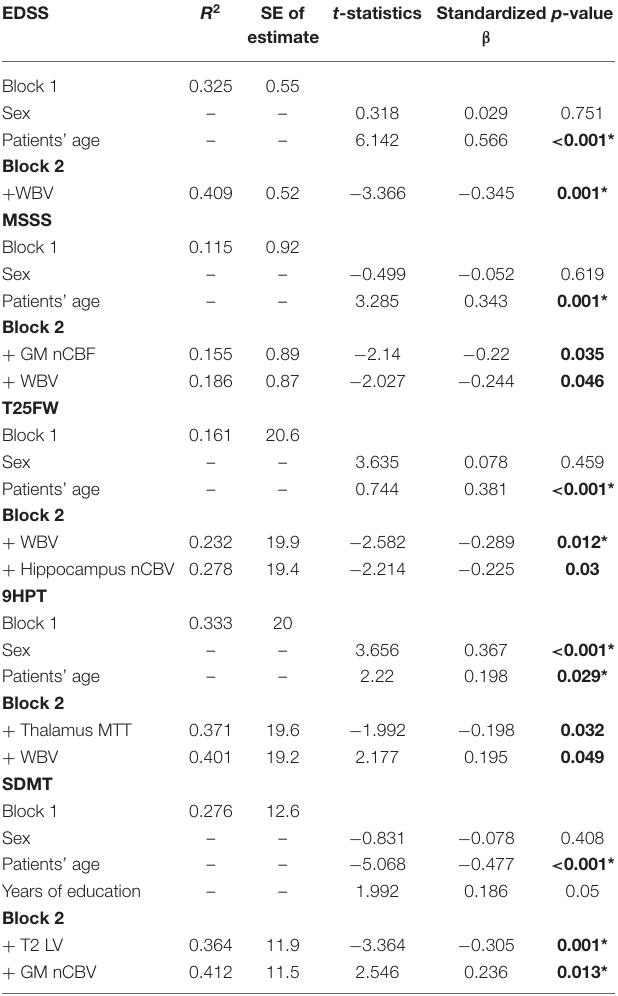
(IBM, Armonk, NY, USA). The data distribution was assessed by Kolmogorov-Smirnov test and by visual inspection of Q-Q TABLE 2 | Association between clinical MS scores (EDSS and MSSS) and plots. EDSS and MSSS were normalized by natural logarithmic MRI-derived measures. transformation. For normalization of T25FW and 9HPT, t -statistics Standardized EDSS R 2 SE of β estimate